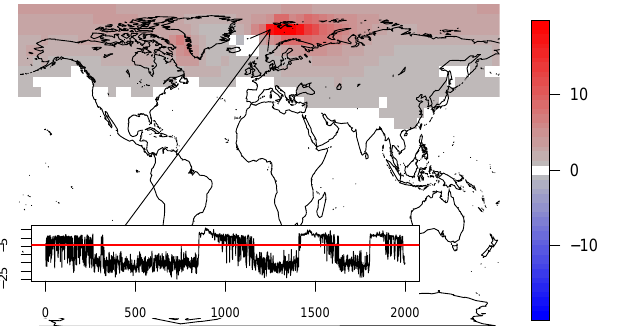
Figure 2. Slow oscillations developing in experiment 20 ( e = 0 . 040, (cid:36) = 334.6 ◦ , ε = 22 ◦ ). The surface annual temperature over one of the North Atlantic grid points is shown (inset, in ◦ C) along with the geographic distribution of the difference between the warm and the cold phases. The horizontal red line in the inset is the emu- lator prediction, calibrated on the 26 remaining